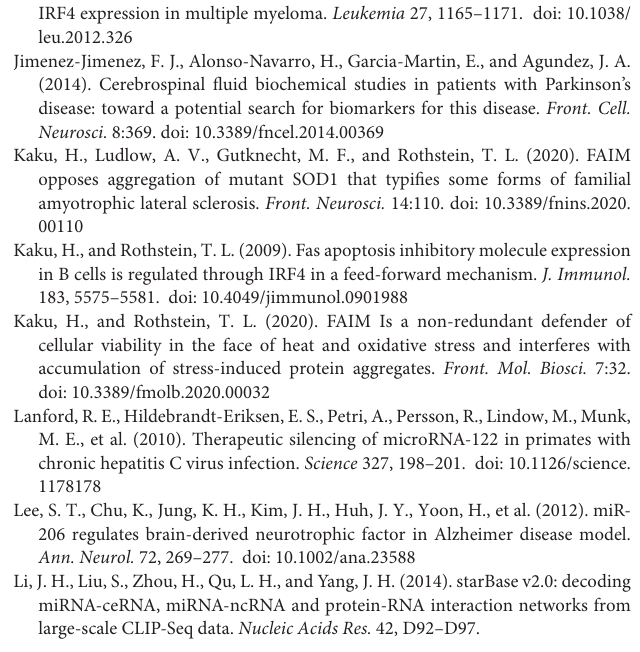
Supplementary Figure 1 | Multiple sequence alignment of 3 (cid:48) UTR FAIM from different species. Sequences included in the alignment are those of Homo sapiens , Mus musculus , Rattus norvegicus, and Sus scrofa . The sequences of miRNA are boxed in blue (miR-140-3p), pink (miR-206;miR-1-3p), and green